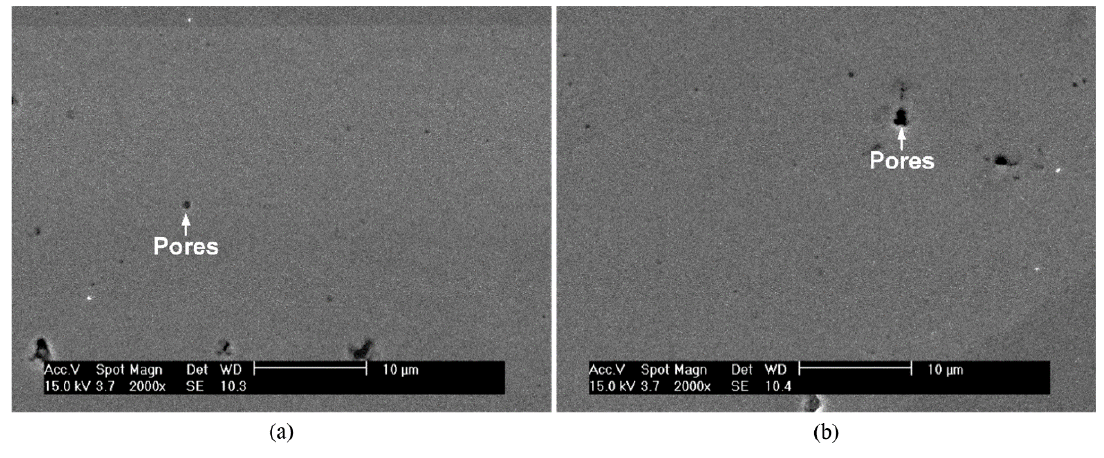
and (b) 20% CH . 4 4